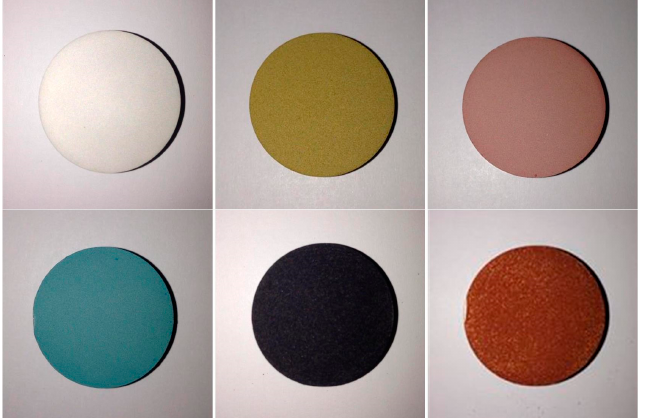
Figure 5. Colorful PEO coatings on the 6061 Al-alloy sample. Reprinted with permission from [110]; Copyright 2016 Elsevier. These colors have been created through in-situ incorporation of several organic dyes under constant voltage mode via path 5 in form of direct micro-emulsion.